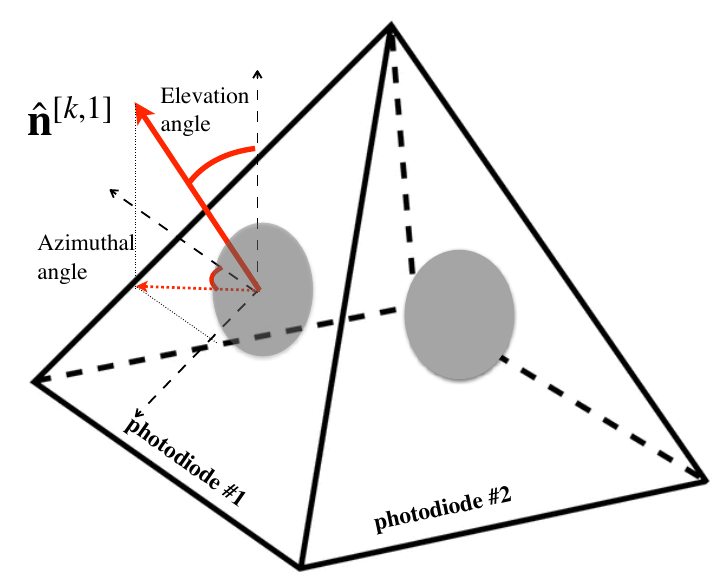
Figure 8. Pyramidal arrangement for an ADR comprising 4 PDs.